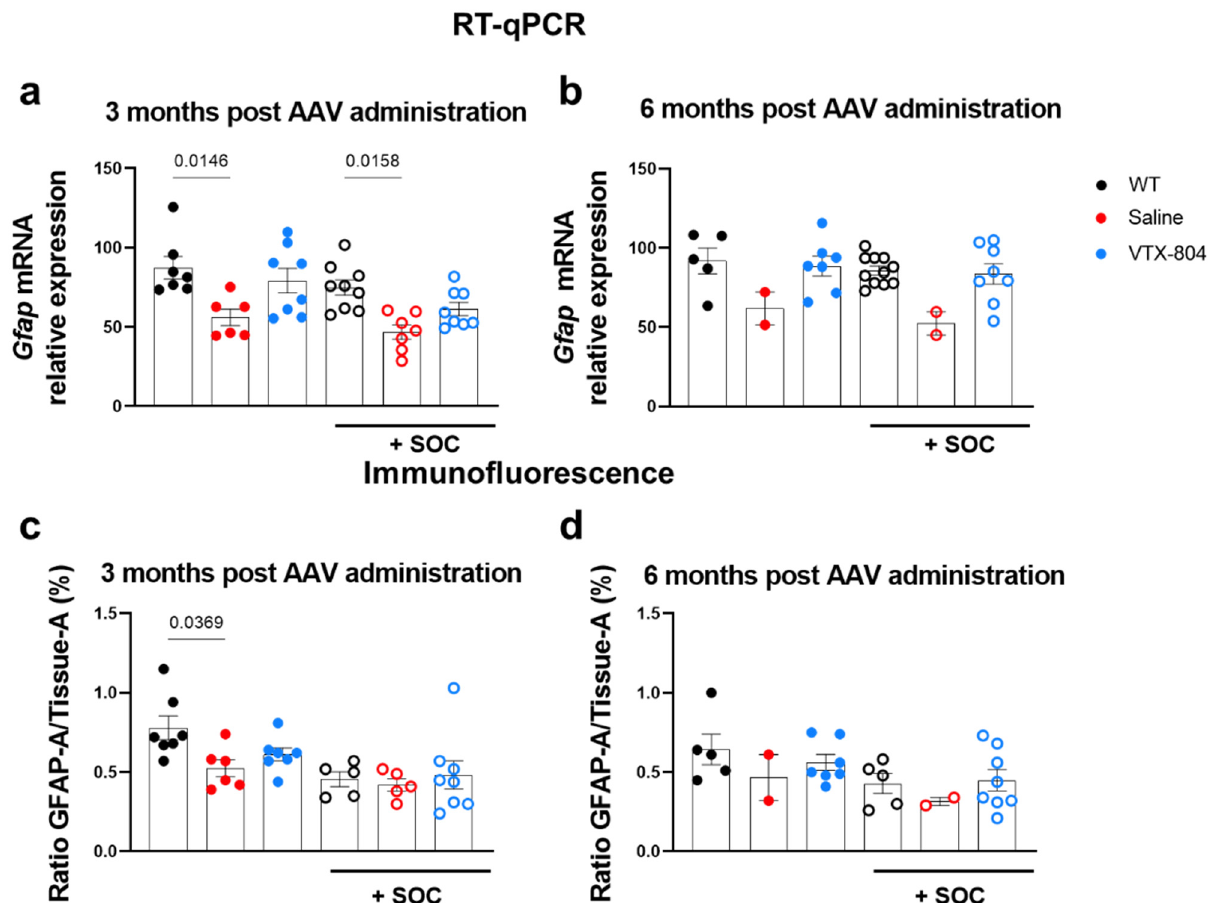
Figure 6. Ass1 fold mice showed a moderate reduction of Gfap expression in brain. At 3 weeks of age, Ass1 fold mice were injected with the VTX-804 vector (n = 16), at a dose of 1 × 10 14 vg/kg in combination or not with pharmacological treatment. Three or six months later, they were sacrificed for quantification of Gfap expression by RT-qPCR and normalized against histone (*100) ( a , b ) and by immunofluorescence ( c , d ). Quantification of GFAP content obtained from automated quantification with Fiji—ImageJ software and ratio of area GFAP/area tissue (%) represented as mean ± SEM. Group of animals without SOC treatment: Ass1 fold treated with VTX-804 vector (blue closed circles; n = 8). Controls included saline treated Ass1 fold mice (red closed circles; n = 6) and healthy WT mice (black closed circles; n = 7). Groups of animals with SOC treatment: Ass1 fold treated with VTX-804 vector (blue open circles; n = 8). Controls included saline treated Ass1 fold mice (red open circles; n = 7) and healthy WT mice (black open circles; n = 9). Only significant differences ( p < 0.05) are indicated (one-way ANOVA with Bonferroni multiple comparisons test or Kruskal-Wallis with uncorrected Dunn’s test). 3. Discussion Inherited metabolic disorders of the liver represent a substantial number of childhood diseases, their treatment often being limited to supportive measures, which only reduce the risk of metabolic crises and impairment of the quality of life. Up to now, the only established curative treatment for many of these diseases is orthotopic liver transplantation. However, with two products commercialized, or close to being commercialized, the long-lasting therapeutic effects of liver-directed gene therapy achieved in clinical trials for hemophilia A and B using recombinant AAV vectors identify AAV-mediated gene therapy as a very attractive alternative to transplantation in inherited monogenic liver disorders [37].